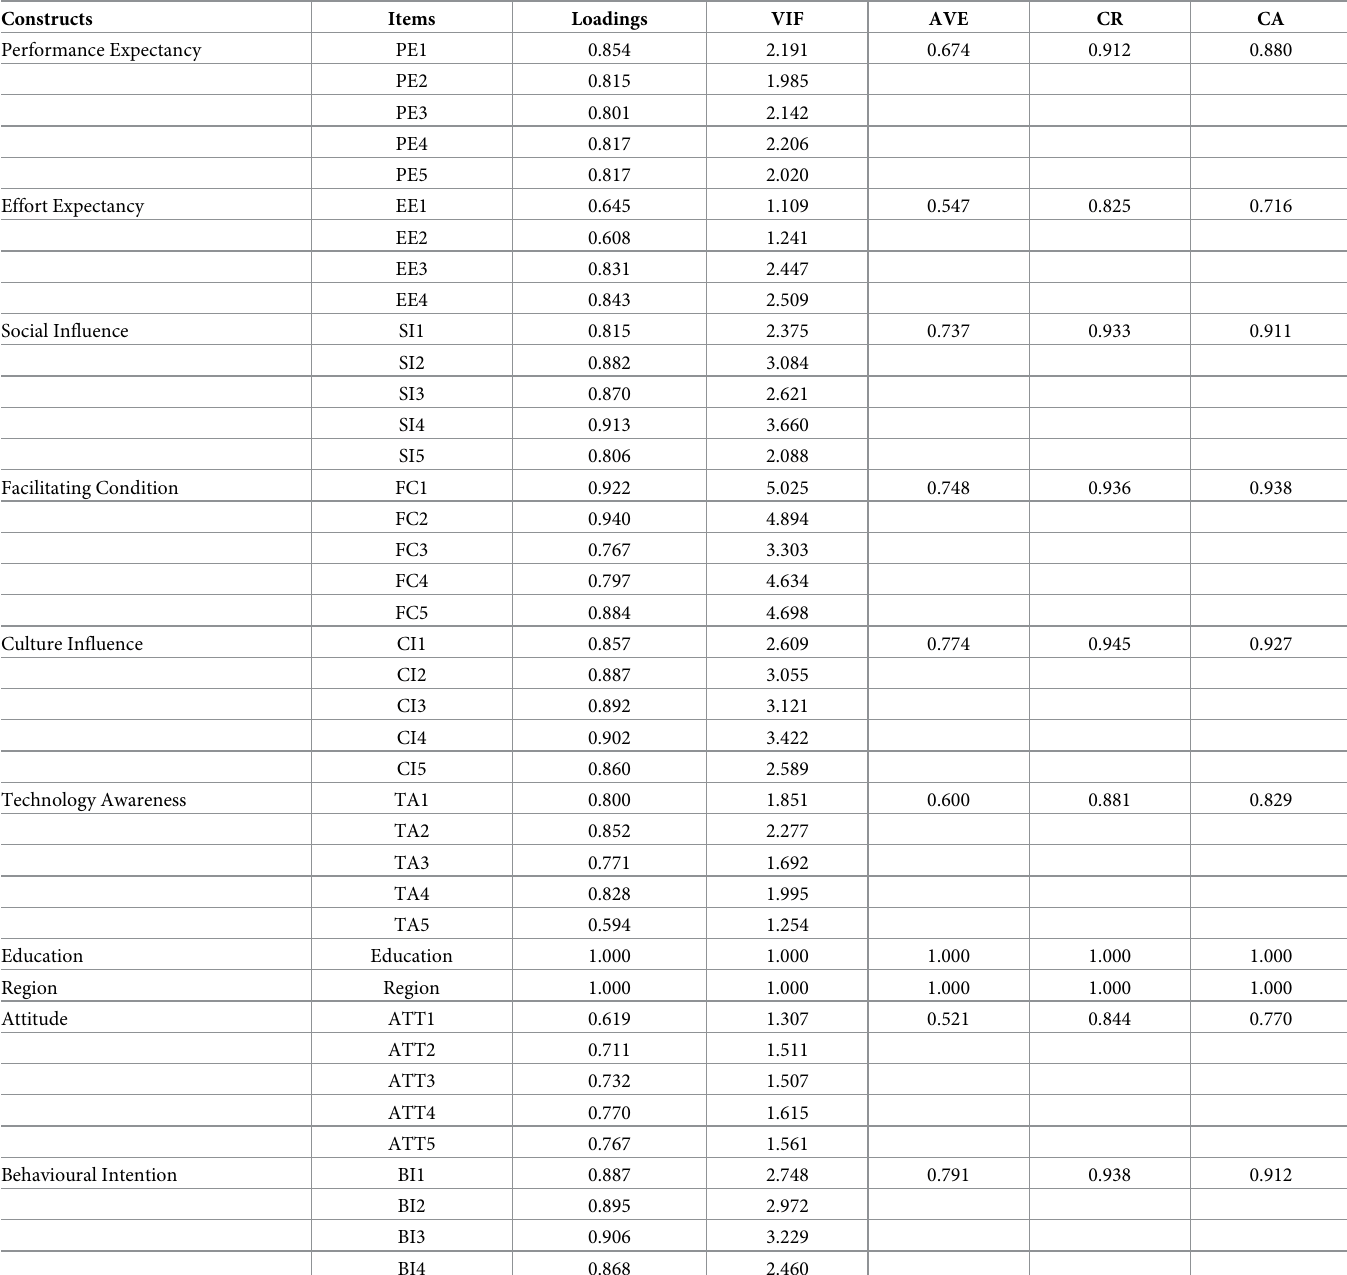
Table 3. Convergent